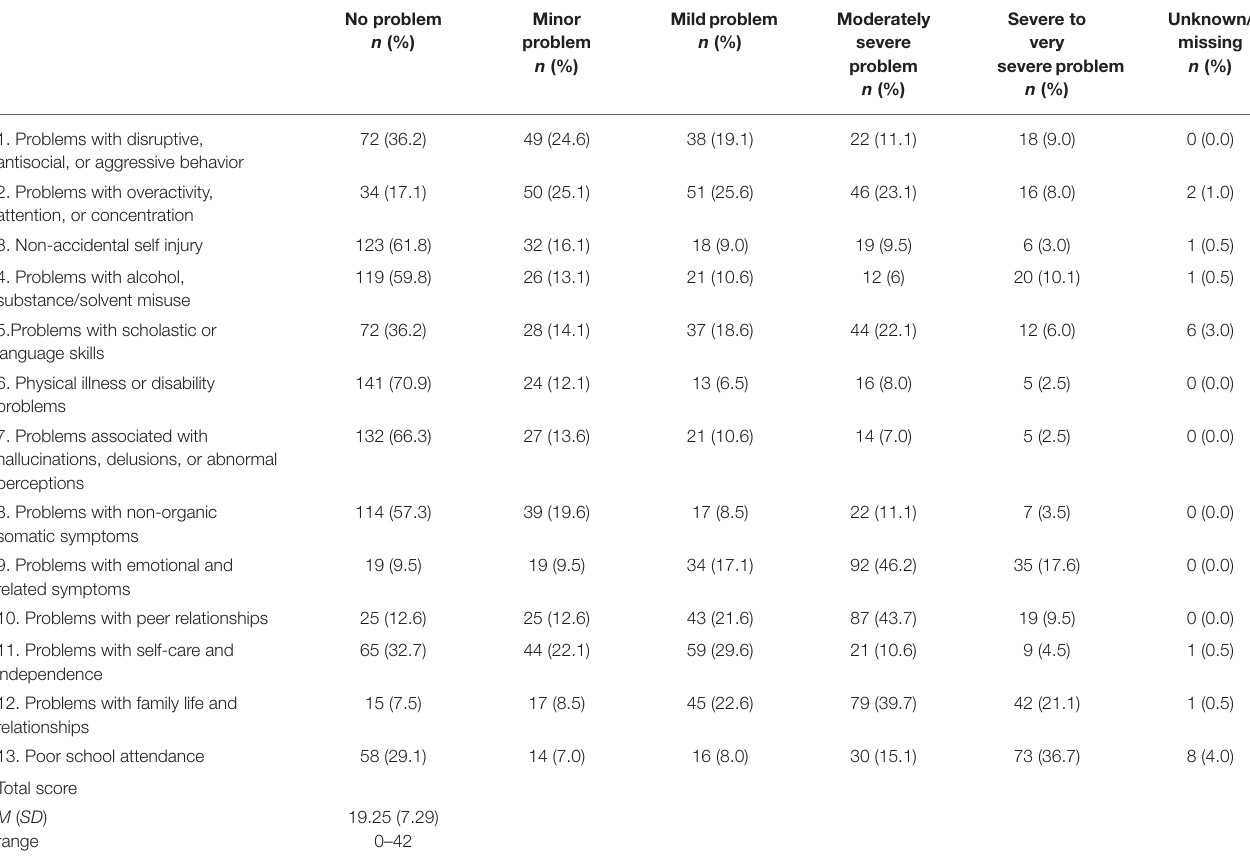
TABLE 7 | Descriptives of the HoNOSCA completed by mental health workers ( n = 199